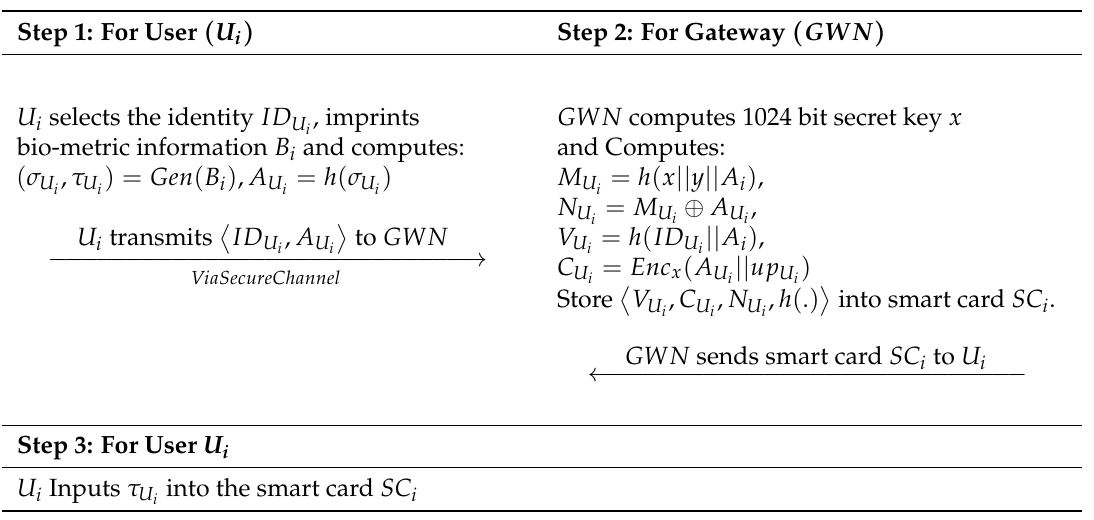
Table 5. User registration phase of Park et al.’s